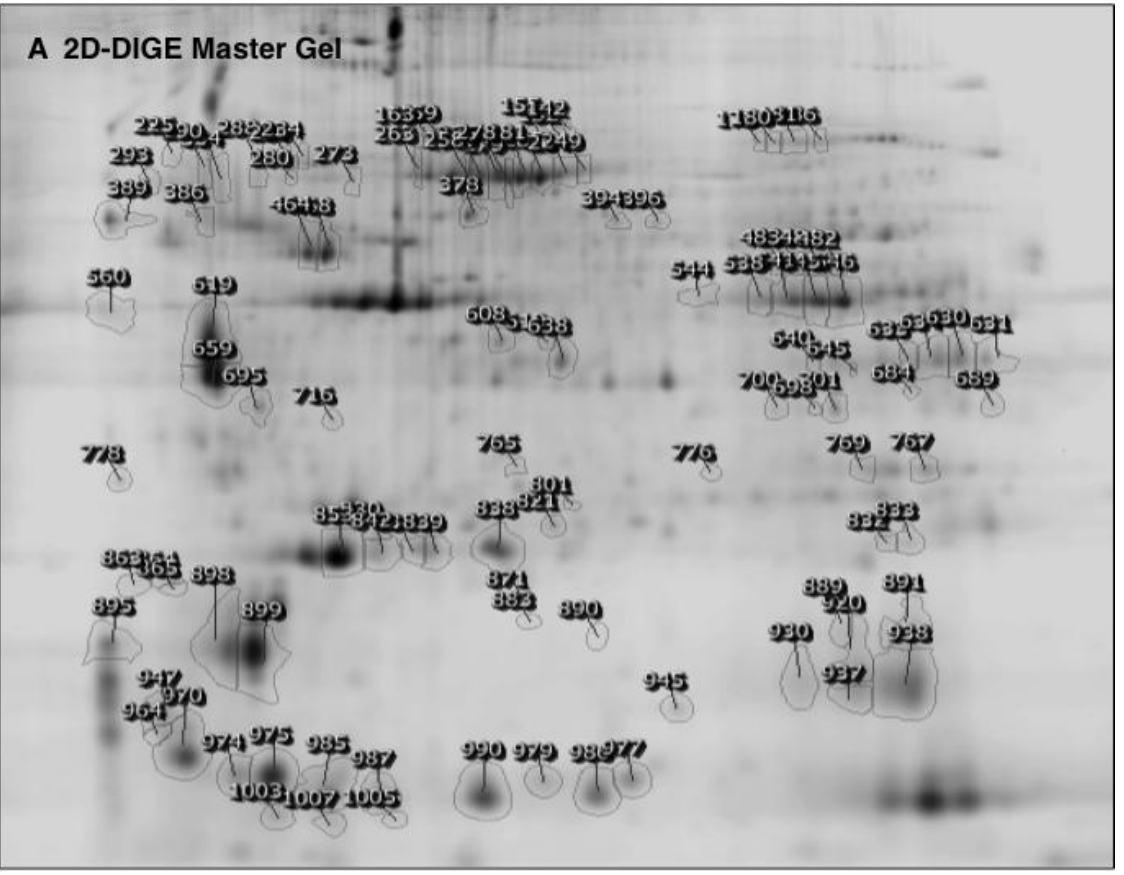
Figure 4. The 2D protein spots with a significant change in abundance are marked by circles and their numbering from 1 to 84 corresponds to the list of identified proteins in Table 1. Figure 3. Image analysis of fluorescent DIGE gels representing normal versus dystrophic diaphragm muscle: Shown are a 2D-DIGE master gel used for the analysis of aged mdx diaphragm ( A ), the visualization of the altered expression levels of the cytosolic Ca 2+ -binding protein parvalbumin (PVA; B , D , E ) and the small molecular chaperone cvHsp ( C , F , G ), the variability of detected alterations between normal and dystrophic samples ( H , I ) and the graphical presentation of the drastic decrease in parvalbumin ( J , K ) and the up-regulation of cvHsp ( L , M ) in dystrophic muscle. In this study, a Typhoon Trio variable mode imager was employed for the visualization of electrophoretically separated and CyDye-labelled diaphragm proteins. Expression changes of proteins between wild type samples and dystrophic mdx samples were determined with the help of Progenesis SameSpots analysis